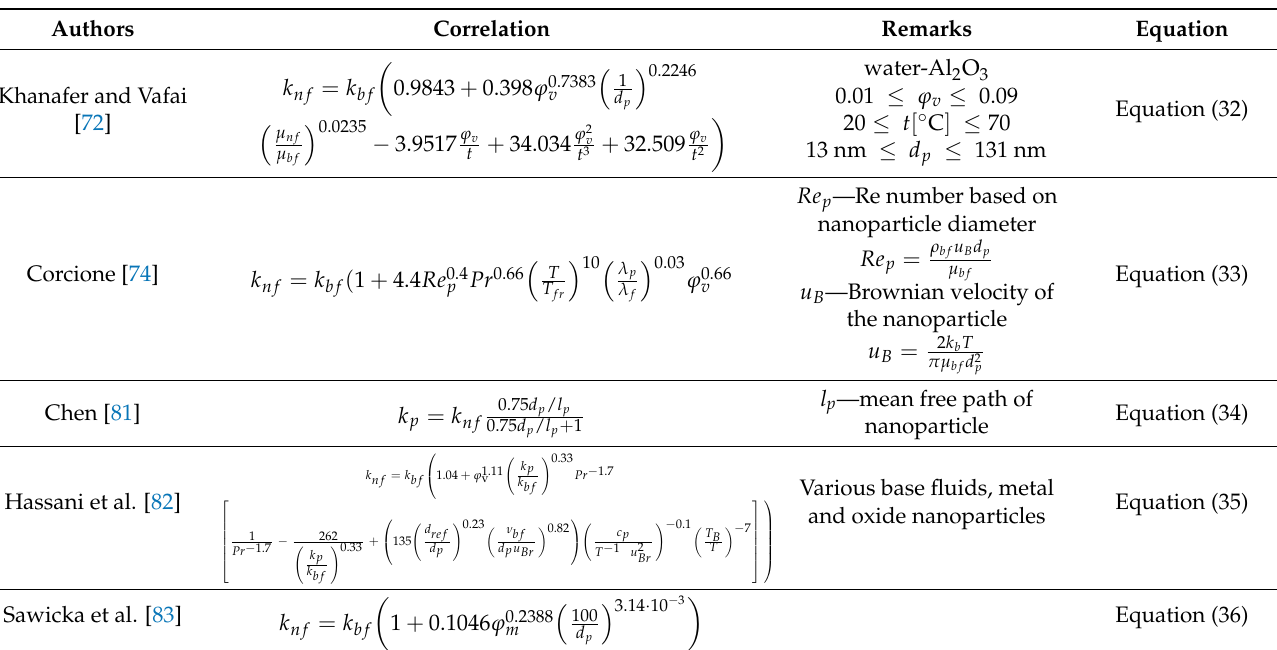
Table 6. Correlations for thermal conductivity of water- Al 2 O 3